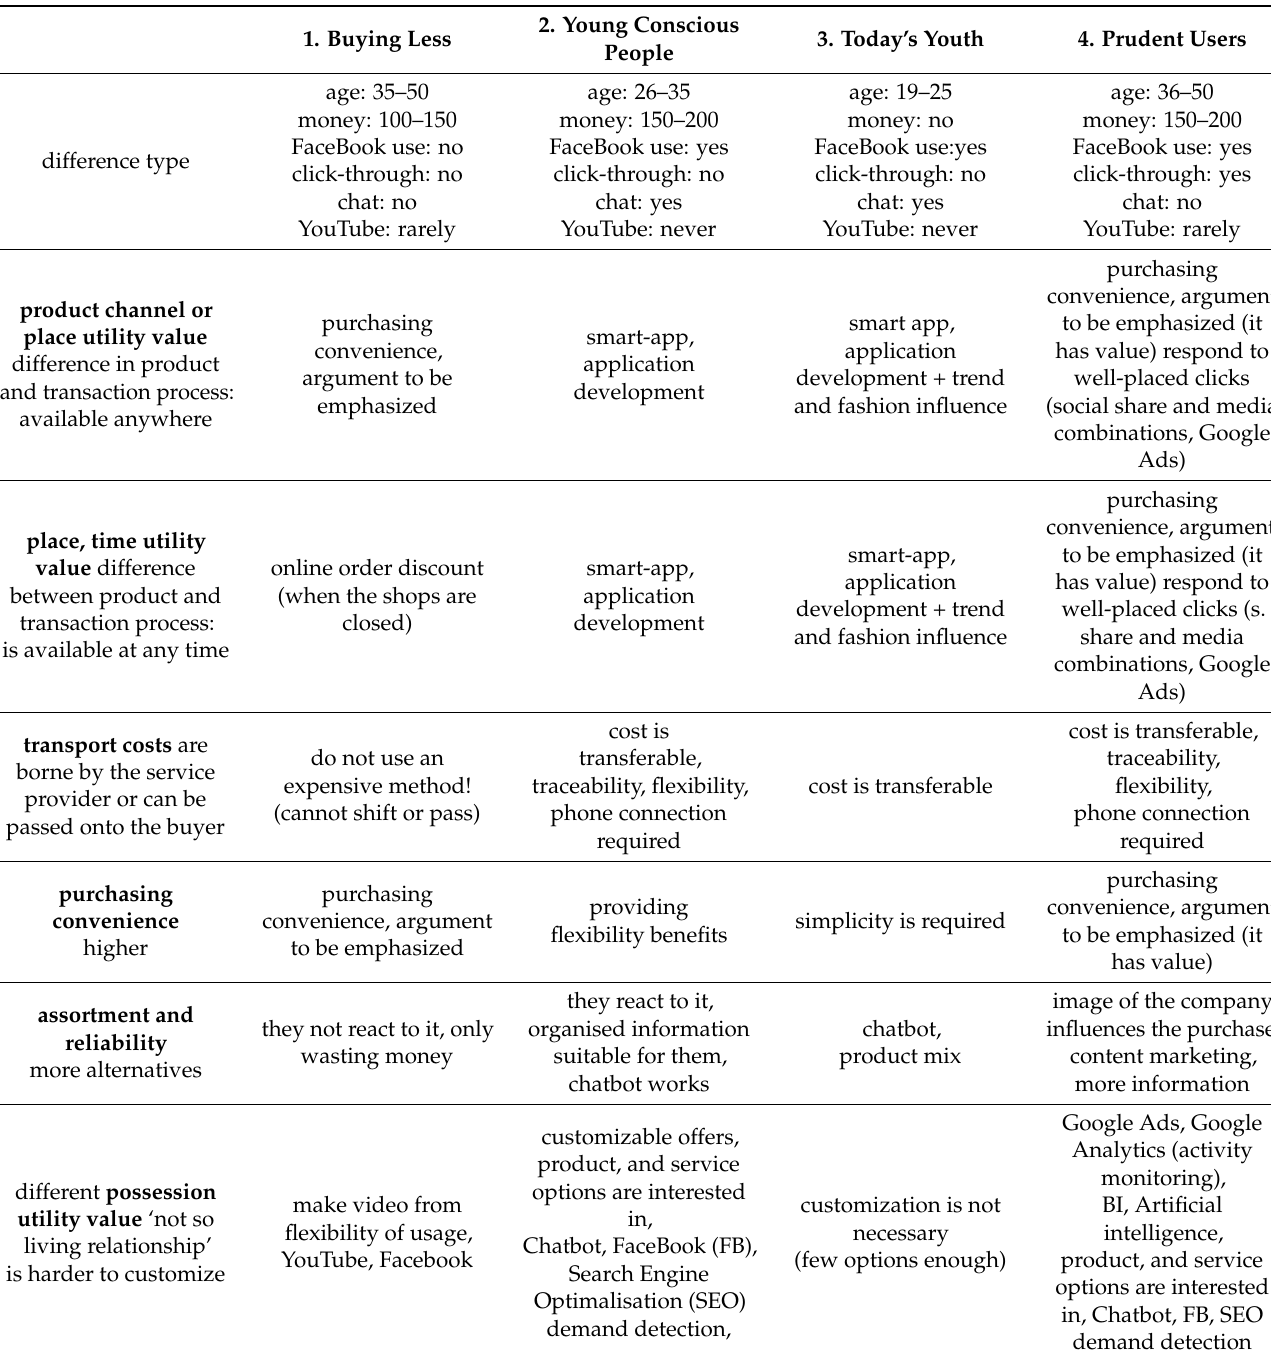
Table 5. Differences of e-commerce and consumer habits according to the group of 4 clusters combination marketing strategic